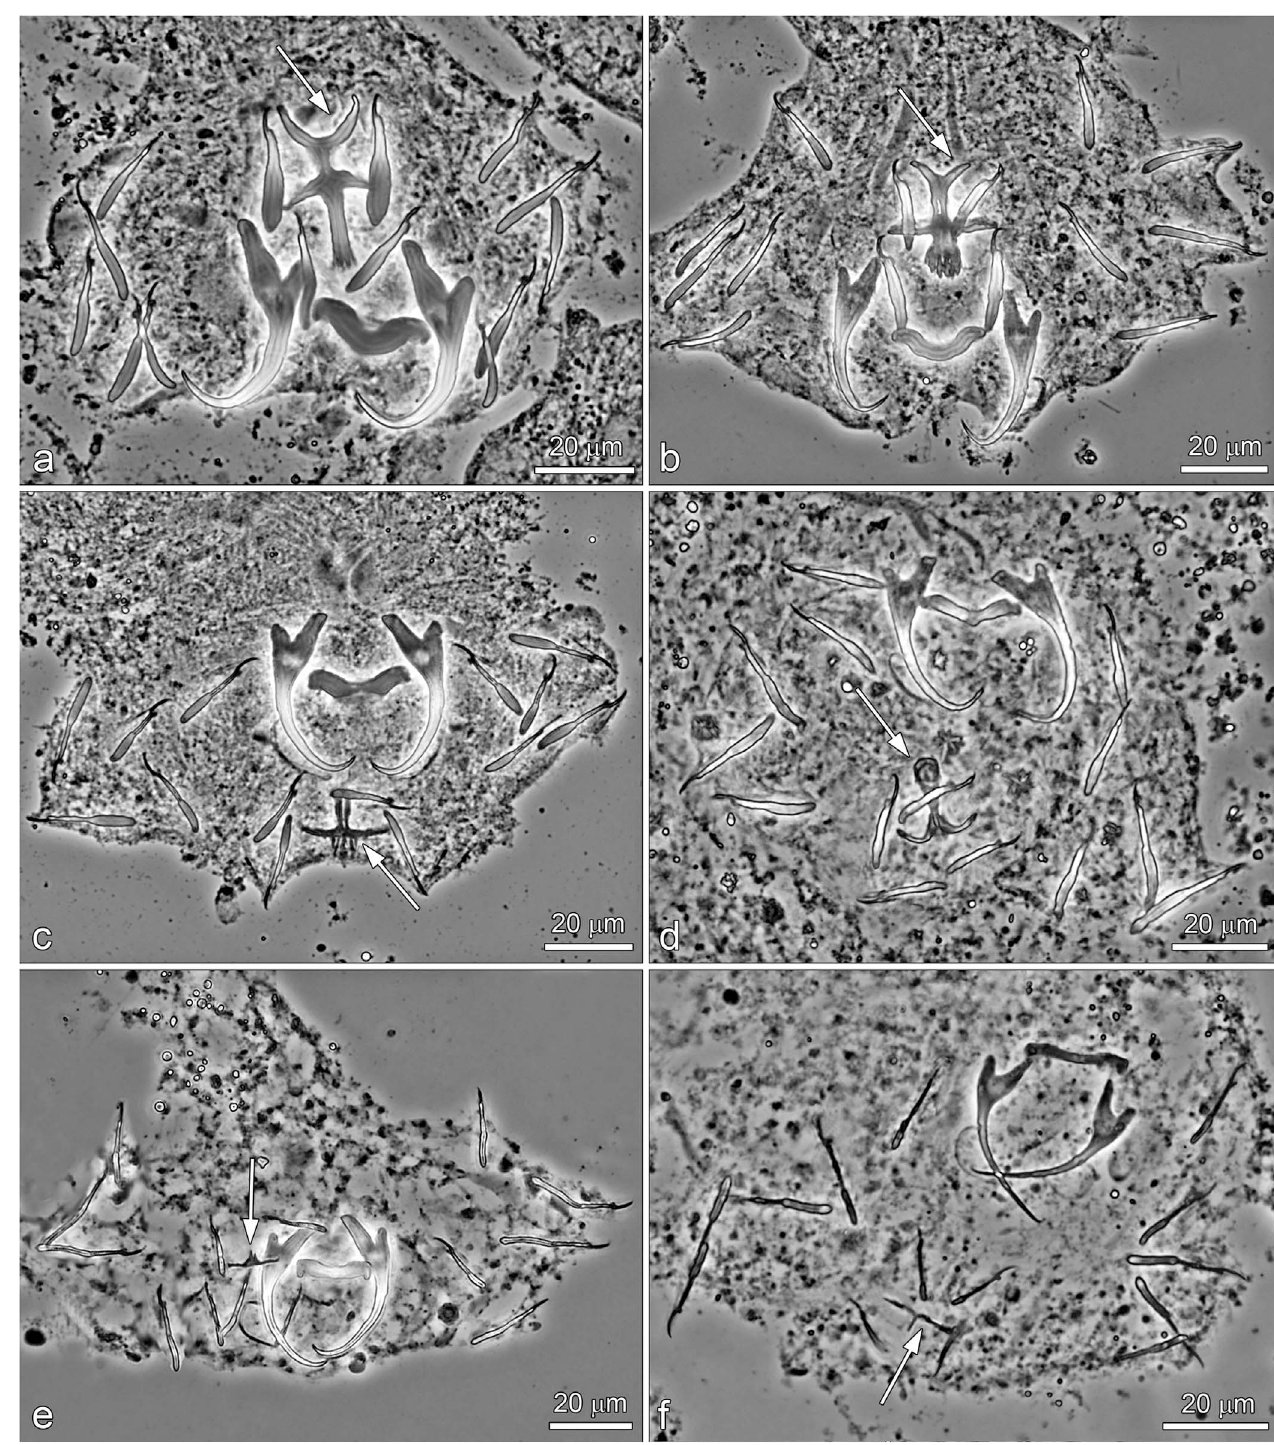
Figure 4. Phase-contrast micrographs of the sclerotized haptoral structures of Dactylogyrus spp. Arrows indicate the shape/type of the ventral bars. (a) D. romuli n. sp. ( fi ve radial type with long terminally frayed posterior arm), (b) D. recisus n. sp. ( fi ve radial type with posterior arm shorter than anterior one and with deeply frayed termination), (c) D. sandai n. sp. (cross-shaped type with posterior arm longitudinally split into several rays), (d) D. octopus n. sp. (inverted T-shaped type with pyriform anterior arm), (e) D. vukicae n. sp. (inverted T-shaped type with anterior arm reduced into several fi nger-like rays), (f) D. leptus n. sp. (poorly sclerotized, inverted T-shaped type with pointed arms of the same